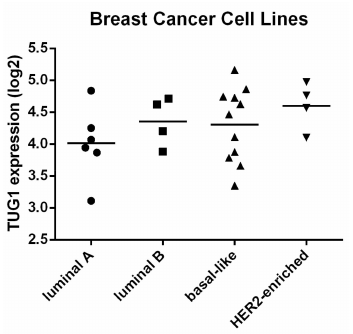
Figure A1. Expression analysis of TUG1 transcript in cell lines. TUG1 expression data were from “TCGA. Symbols represents the number of cell lines analyzed: luminal A ( n = 6), luminal B ( n = 4), HER2-enriched ( n = 4) or basal ( n = 11). Analysis of variance ANOVA was used to examine TUG1 expression across cell lines ( p =